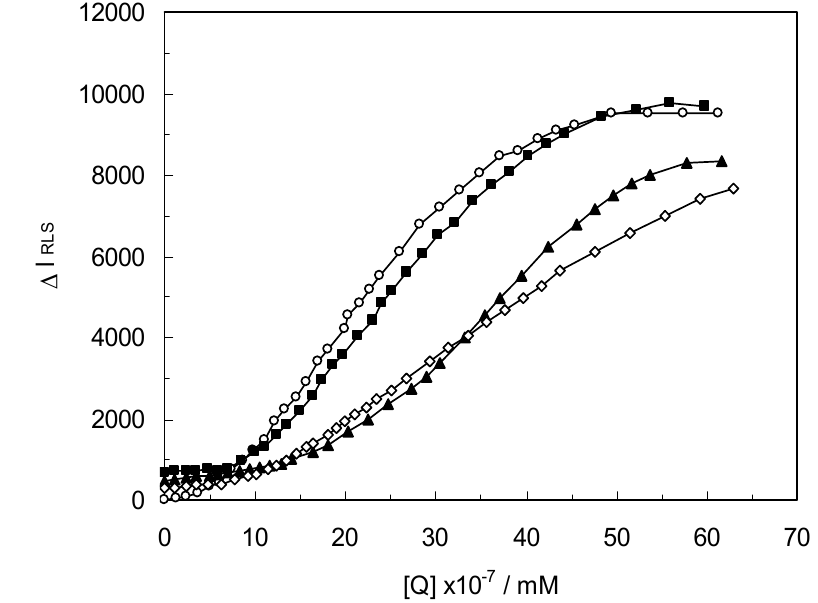
Figure 7. RLS spectra of LYZ in the presence concentrations of CYC in binary LYZ-CYC system( ○ ); in ternary [LYZ-CD( α )]CYC( ■ ), [LYZ-CD( β )]CYC( ◊ ), [LYZ-CD( γ )]CYC( ▲